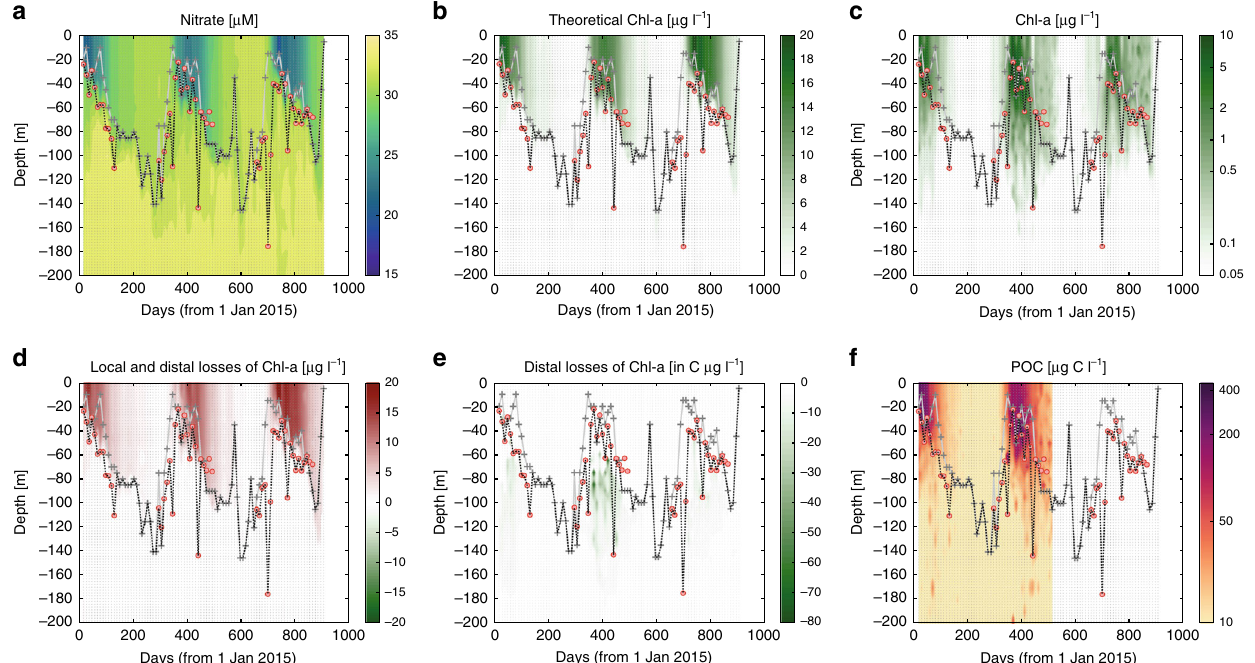
Fig. 2 Biogeochemical observations for fl oat #9099 in the Weddell Sea. Concentration of a nitrate ( µ M), b theoretical maximum chl ( µ g l − 1 ), c measured chl ( µ g l − 1 ), d total losses ( µ g chl l − 1 ), e distal losses ( µ g C l − 1 ), and f particulate organic carbon (POC, µ g C l − 1 ) in the upper 200 m. Thick dashed line indicates the deepest of the euphotic zone depth (Zeu, red circles) de fi ned from Ref. 59 , and the mixed layer depth (grey crosses and grey line) de fi ned from Ref. 58 , as the depth at which density increased by 0.01 kg m − 3 compared with density at the surface. Winter mixed layer across all seven fl oats varied from 90 to 175 m deep, averaging 125 ± 6 m. Thin dashed lines indicate fl oat pro fi les.